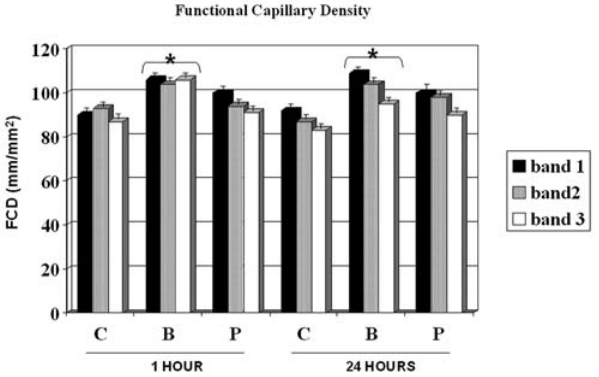
Figure 3 - The functional capillary density on bands I, II, and III among the control (C), Buflomedil (B), and Pentoxifylline (P) groups. These groups were evaluated 1 and 24 h after skin flap preparation. *p < 0.05 compared to controls distances (control = 2.73 cm, buflomedil = 2.78 cm, and